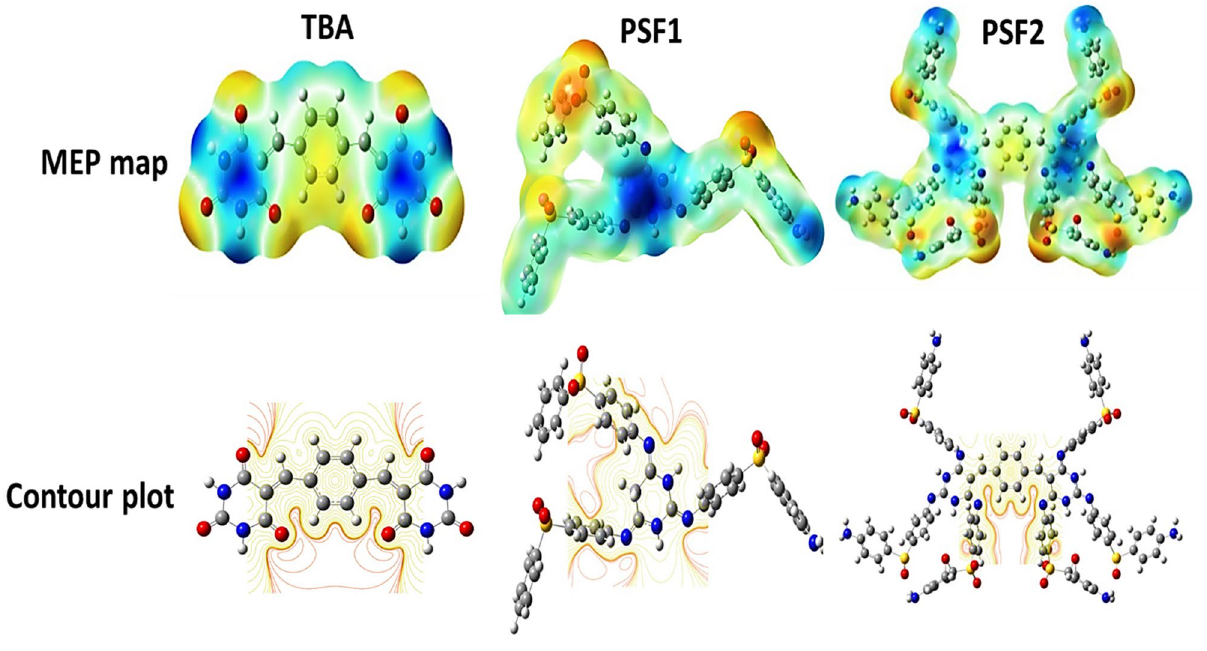
Figure 4. MEP and Contour of TBA, PSF1, and PSF2 were calculated using DFT, B3LYP/6-31G(d,p). Atom color code: C (gray), H (white), O (red), N (blue) and S